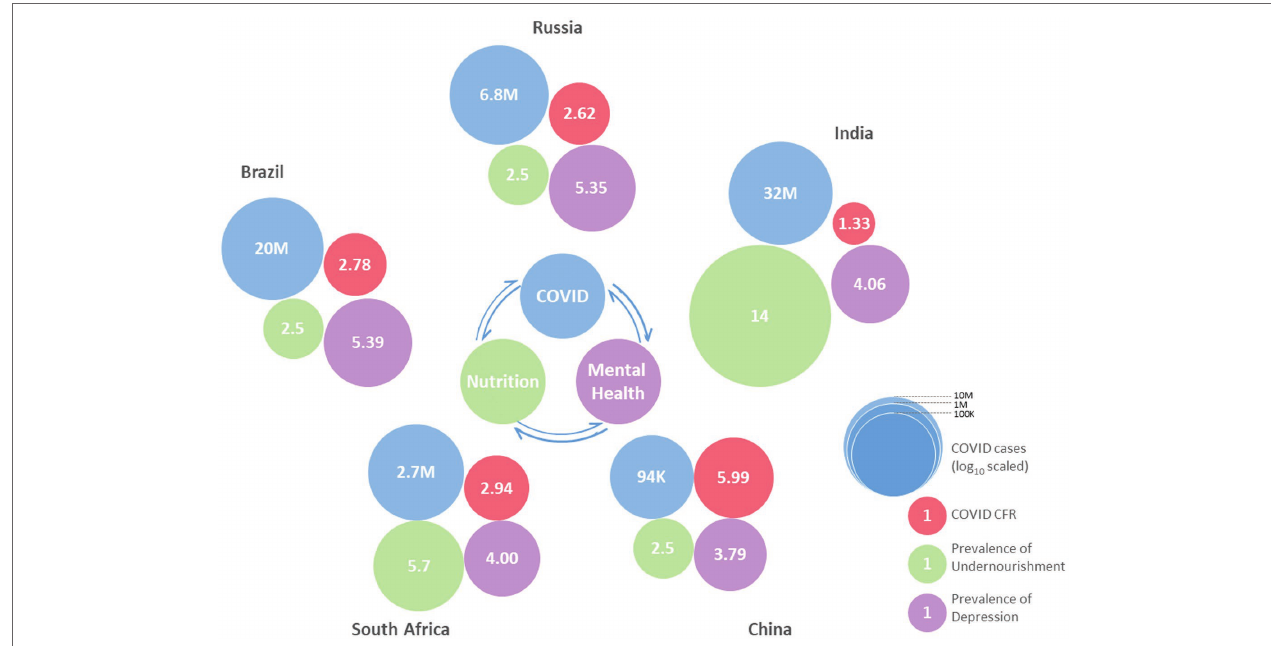
FIGURE 7 | Set-up of COVID-19 cases, case fatality rate (CFR), undernourishment, and mental disorders in BRICS